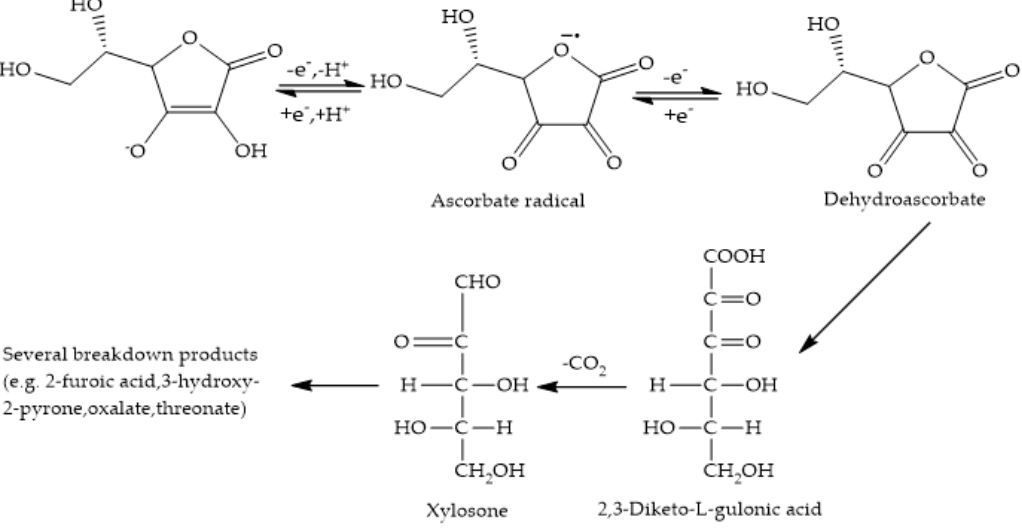
Figure 2. Structure of ascorbate and its oxidation and degradation products [23].